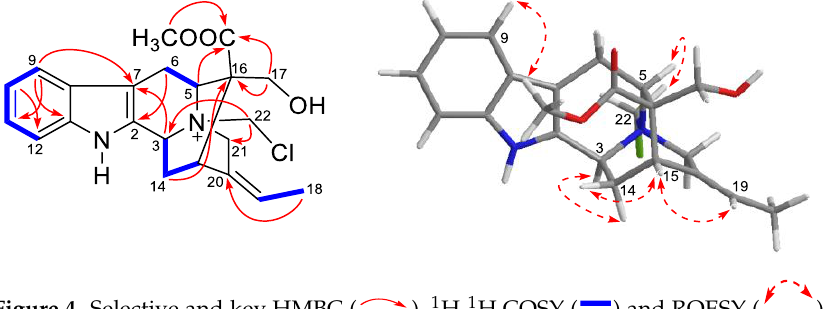
Figure 4. Selective and key HMBC ( ), 1 H- 1 H COSY ( ) and ROESY ( ) correlations of